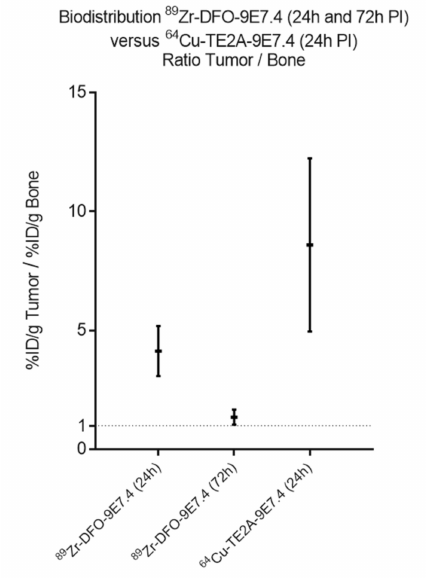
Figure 9. Tumor-to-bone ratios of 89 Zr-DFO-9E7.4 and 64 Cu-TE2A-9E7.4. Tumor-to-bone ratios of 64 Cu-TE2A-9E7.4 at 24 h post-injection (PI) and 89 Zr-DFO-9E7.4 at 24 h and 72 h PI in the subcutaneous tumor model ( n = 3 for each group). Values are expressed in percentage of the injected radioactive dose per gram of tissue (%ID / g) and presented as mean ±